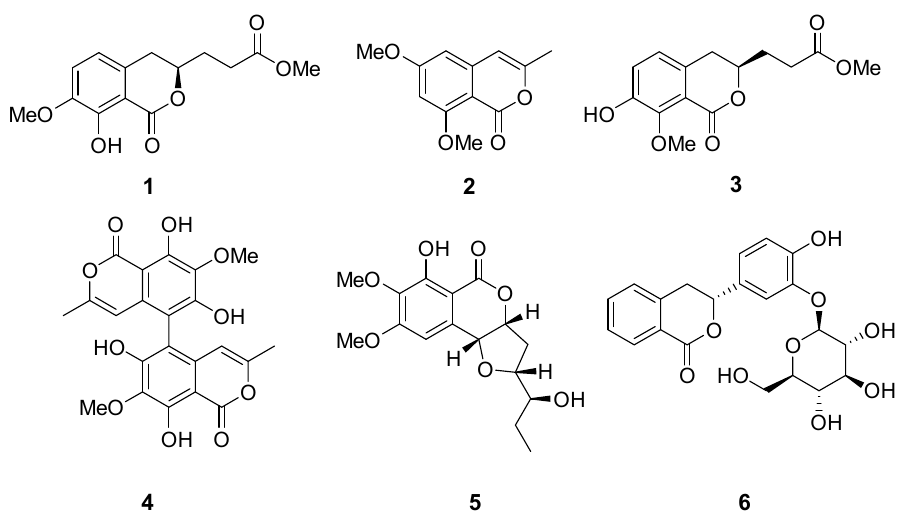
Figure 1. Representative examples of isocoumarin derivatives with demonstrated biological activi- ties.